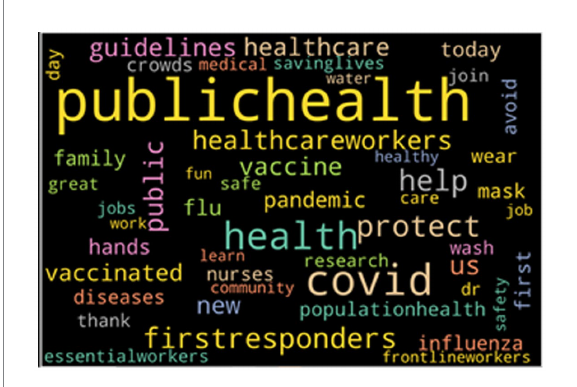
FIGURE 1 The topic 50 keywords from the entire dataset.